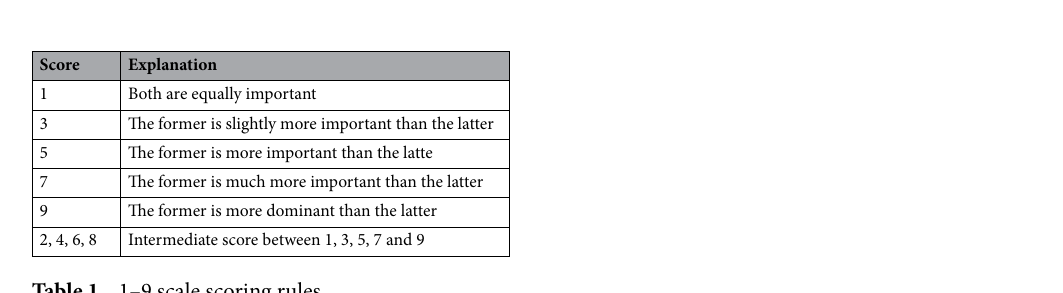
Table 1. 1–9 scale scoring